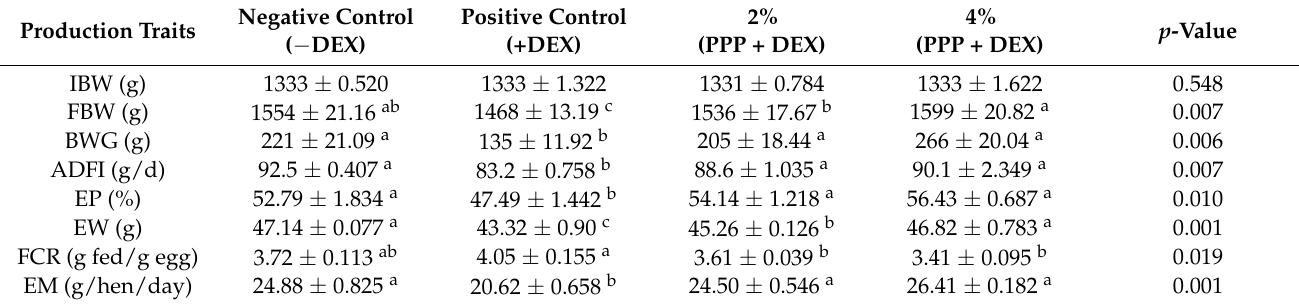
Table 3. Effect of different levels of dietary pomegranate peel on the performance of laying hens subjected to oxidative stress. Production